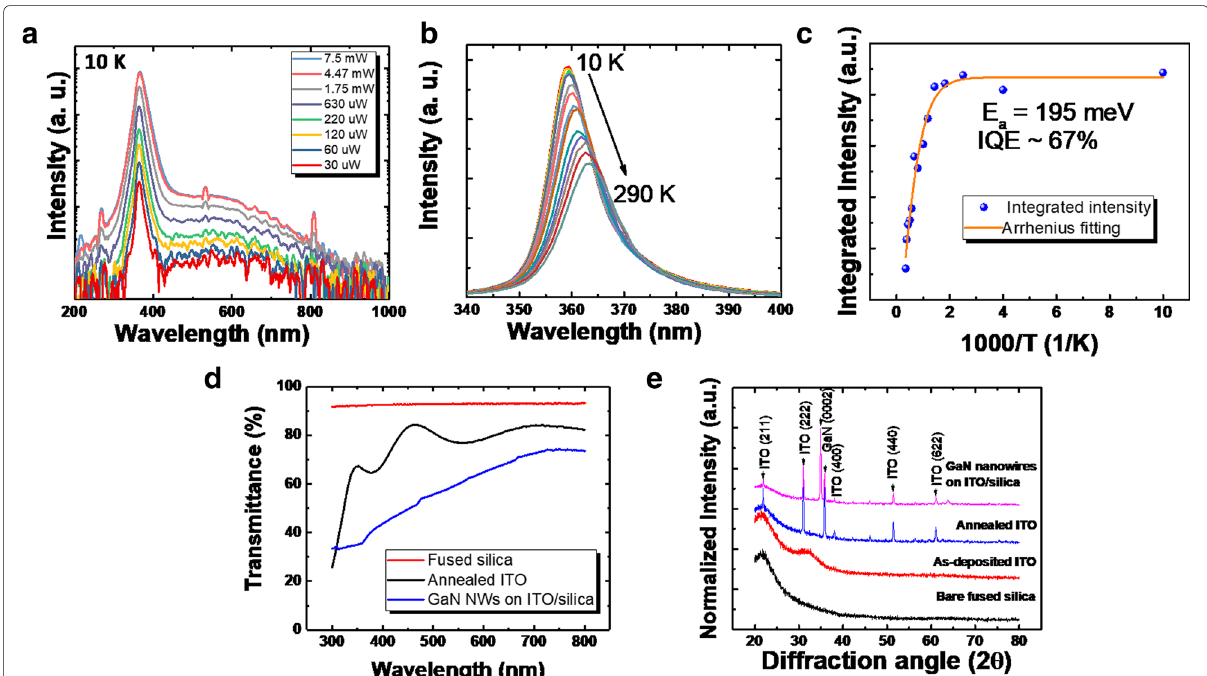
Fig. 4 a Power-dependent measurement of GaN nanowires grown on Indium Tin Oxide performed at 10 K. b Temperature-depende nt PL of GaN nanowires grown on ITO layer. c Calculated activation energy based on temperature-dependent PL measurement. d Transparency of fused silica substrate, annealed ITO layer on fused silica, and GaN nanowires grown on ITO layer; e The XRD profiles for bare fused silica, as-deposited ITO thin film, annealed ITO thin film, and GaN nanowires grown on ITO